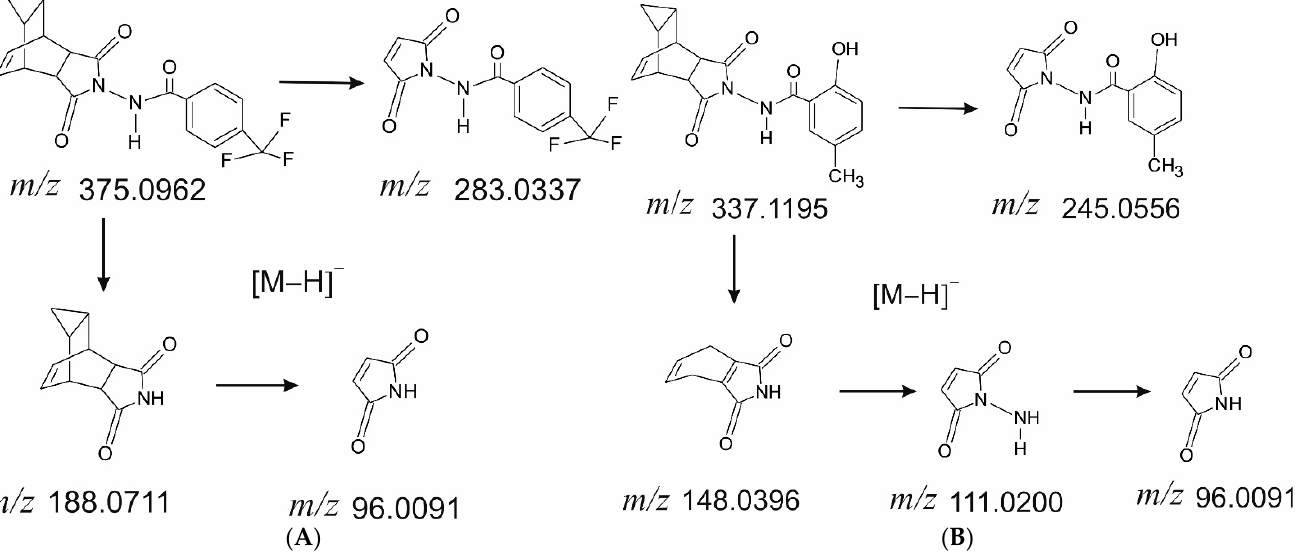
Figure 2. Structures of fragment ions of ST ‐ 246 ( A ) and the IS ( B ).